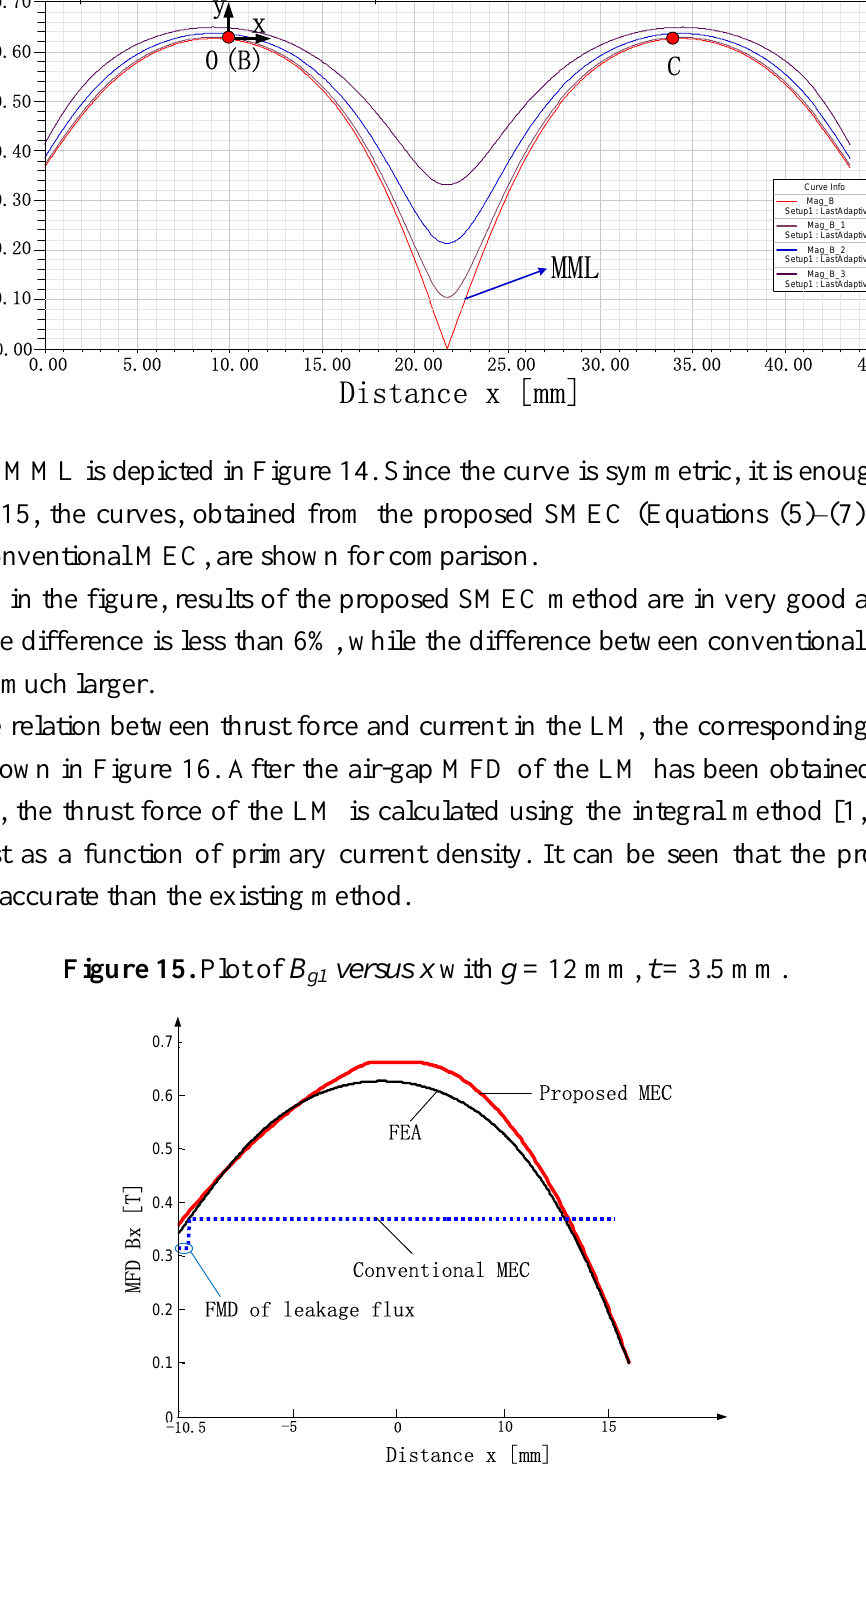
Figure 14. Variation of the MFD with x .